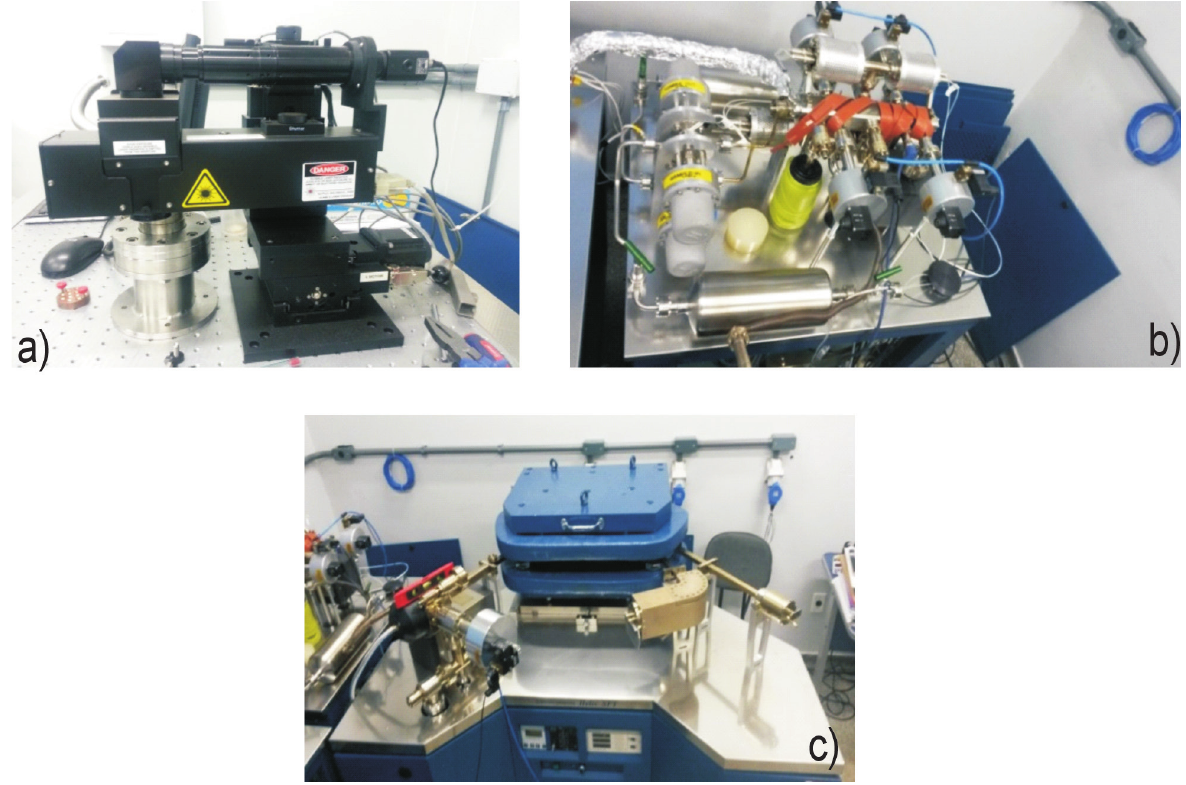
Figure 1 - Photograph of the gas extraction, purification and measurement system; ( a ) laser heating system, ( b ) gas purification bench, and ( c ) helix-SFt noble gas mass